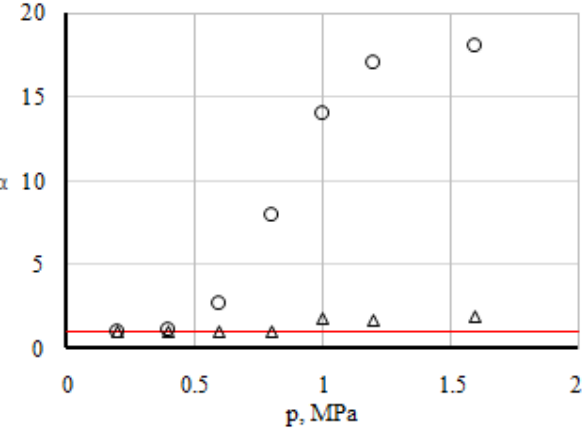
Figure 2. Dependence of α on pressure. The line is the calculation with the assumption of diffusion. The points correspond to: Δ —hydrogen; ○ —carbon dioxide.